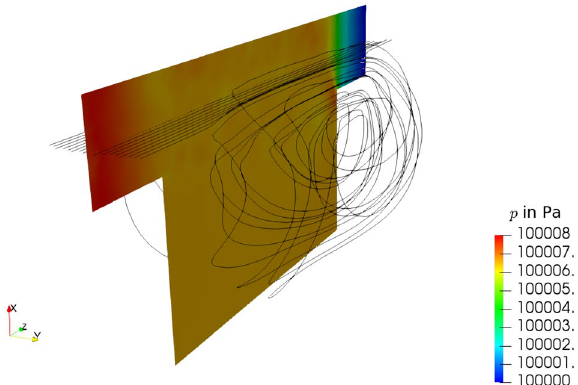
Fig. 14 Computational results are presented for case g, in color the pressure distribution and streamlines emanating at the central plane of the inlet